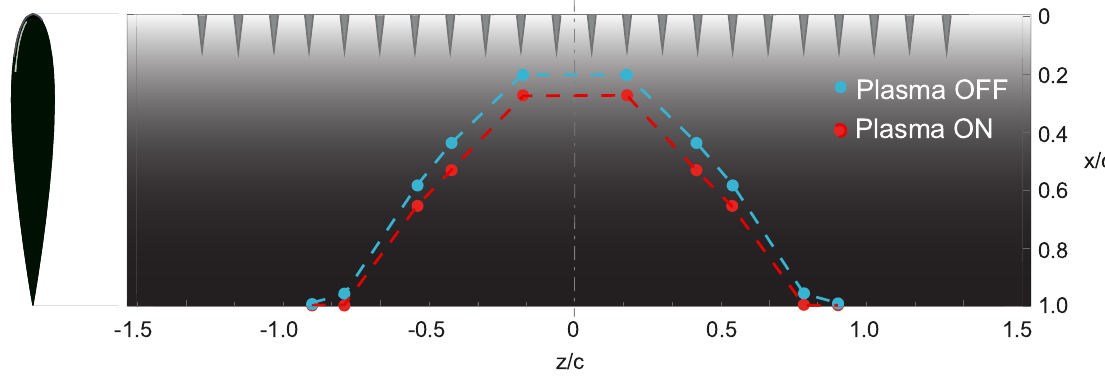
Figure 22. Sketch of the separated region for α = 14.5 ◦ and U ∞ = 30 m/s.